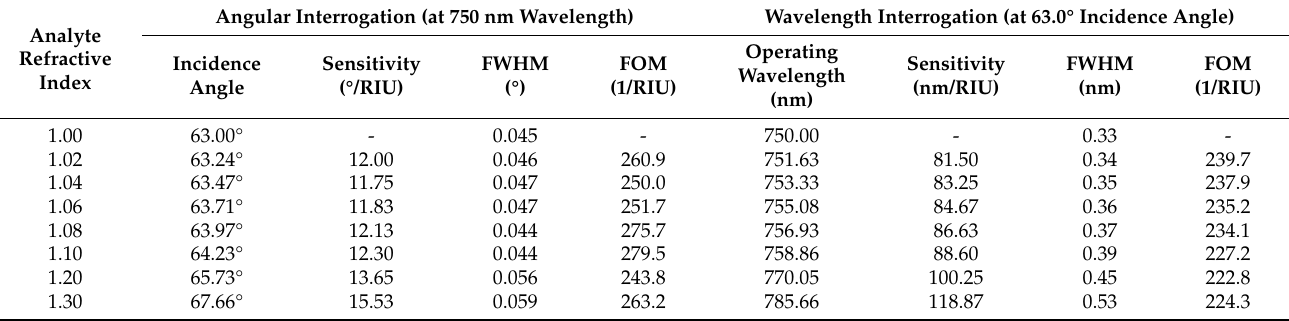
Table 2. Summary of sensitivity analysis for both angular and wavelength